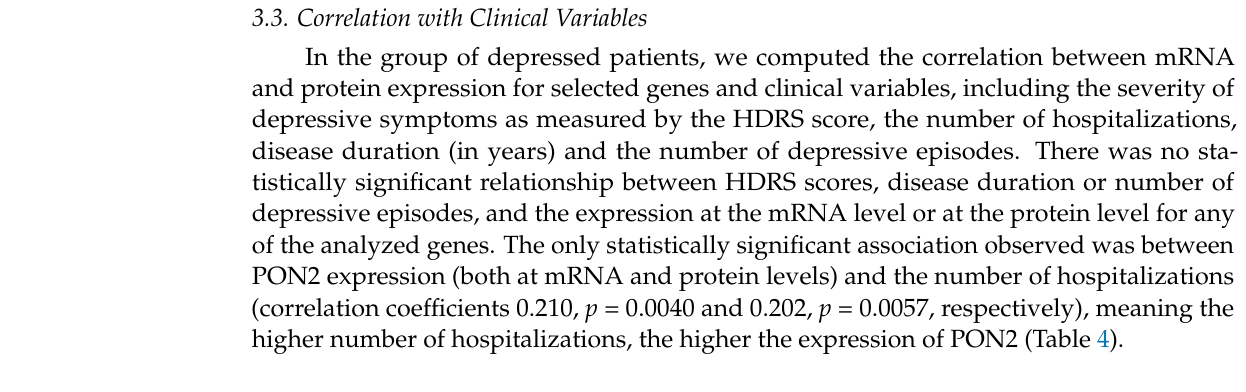
Table 4. Correlation between gene expression and clinical variables. * indicates statistical